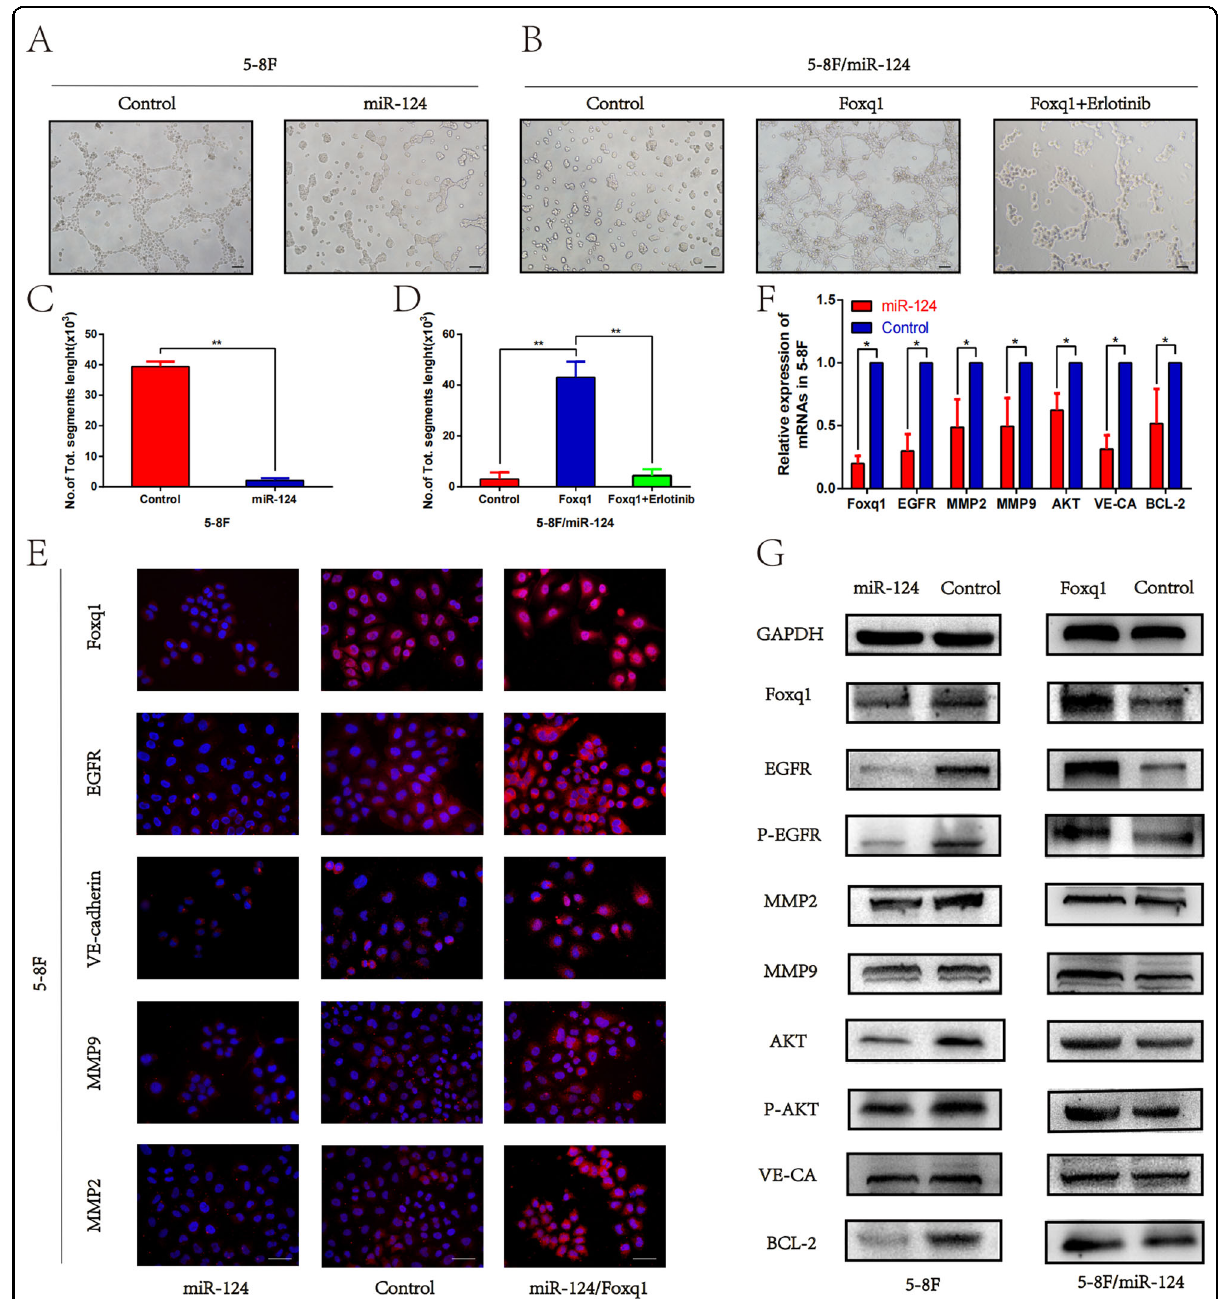
Fig. 7 MiR-124 inhibits the EGFR signaling pathway and VM formation, that could be rescued by Foxq1 expression. A VM channel formation in miR-124 overexpressing and control 5 – 8F cells (magni fi cation, ×200); Scale bars represent 50 μ m. B VM channel formation in 5 – 8F cells that overexpressed both Foxq1 and miR-124; p < 0.001. Foxq1 could signi fi cantly reverse the inhibitory effect of miR-124 on VM formation, which could be inhibited by Erlotinib (magni fi cation, ×200); Scale bars represent 50 μ m. C , D The statistical results of the average number of tubular structures in each group. E Immuno fl uorescence staining of Foxq1, EGFR, VE-cadherin, MMP2 and MMP9 in 5 – 8F cells that overexpressed miR-124, control or simultaneously Foxq1 and miR-124, respectively; scale bars represent 50 μ m. qRT-PCR ( F ) and western blot ( G ) were used to monitor the expression of EGFR signaling pathway and VM-related genes in 5 – 8F cells that overexpressed miR-124, control or simultaneously Foxq1 and miR-124, respectively. Data are presented as mean ± SD of three independent